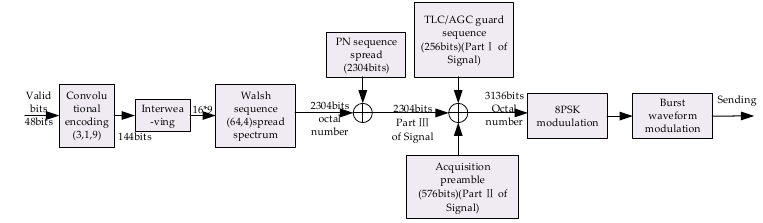
Figure 3. The transmission scheme of burst waveform BW1.